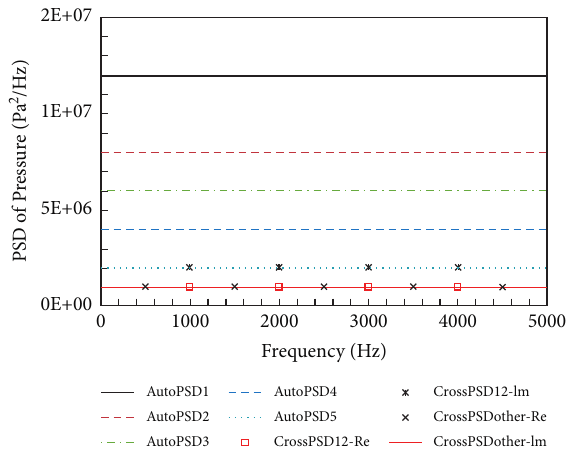
Figure 14: The PSD curves of fluctuating pressures.